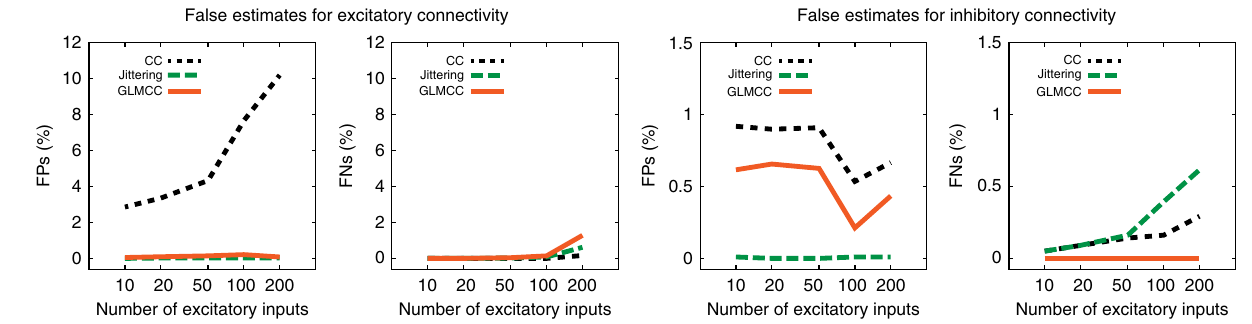
Fig. 7 The number of estimation errors computed for networks of 10,000 LIF neurons. Horizontal axes represent the average number of excitatory inputs to each neuron. For excitatory (inhibitory) connectivity, FPs represent directed links that were mistakenly assigned as excitatory (inhibitory), whereas FNs represent excitatory (inhibitory) connections that were assigned as disconnected or inhibitory (excitatory). Source data are provided as a Source Data